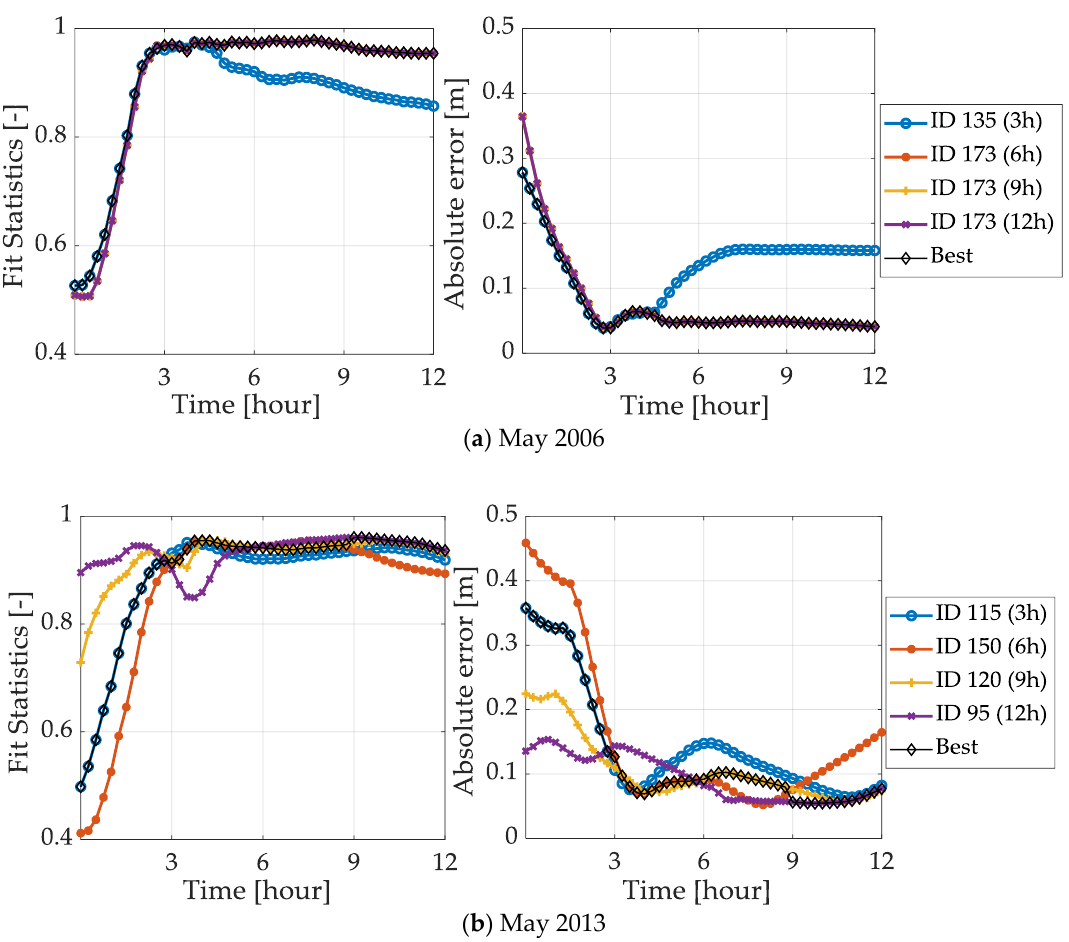
Figure 13. Update of the map selection for the convective events: ( a ) May 2006 and ( b ) May 2013.